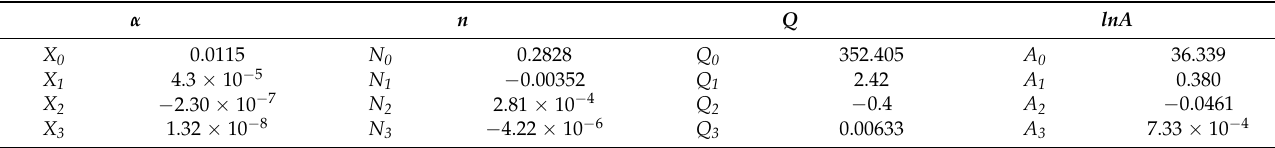
Table 7. Third-order polynomial fitting results of parameters with strain for α + β phase